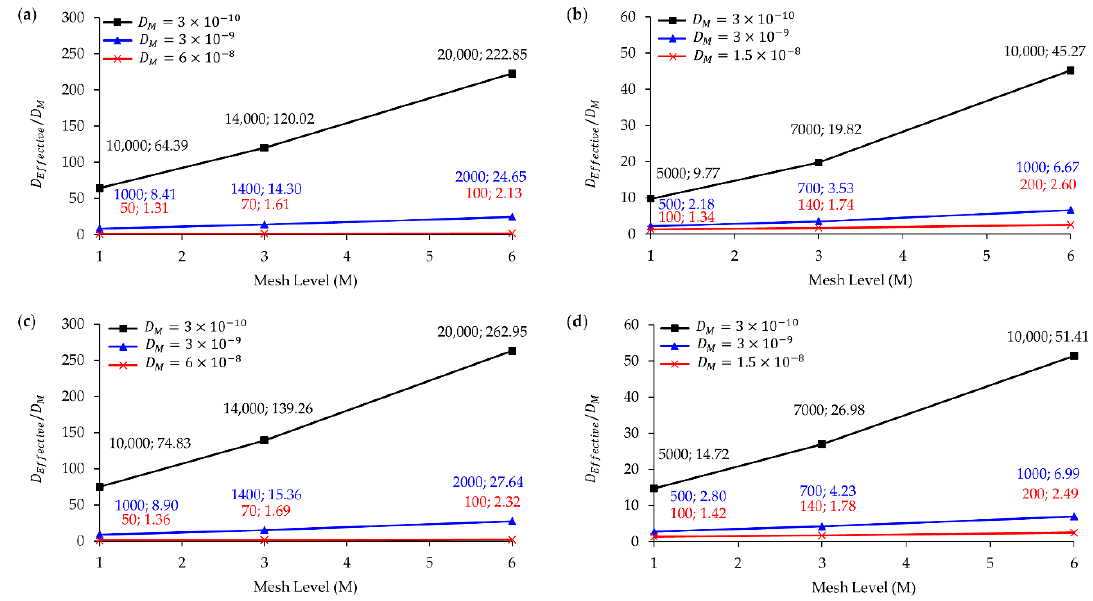
Figure 15. The ratio of effective diffusivity (m 2 /s) and molecular diffusivity (m 2 /s) vs. mesh levels (M1, M3, and M6): ( a ) and ( c ) four-inlet and two-inlet designs at Re = 240, respectively; ( b ) and ( d ) four-inlet and two-inlet designs at Re = 120 respectively. The semicolon-separated numbers above the trend lines (corresponding to line color) show the average Pe ∆ number (left) and y -axis value (right) for mesh levels and flow scenarios.